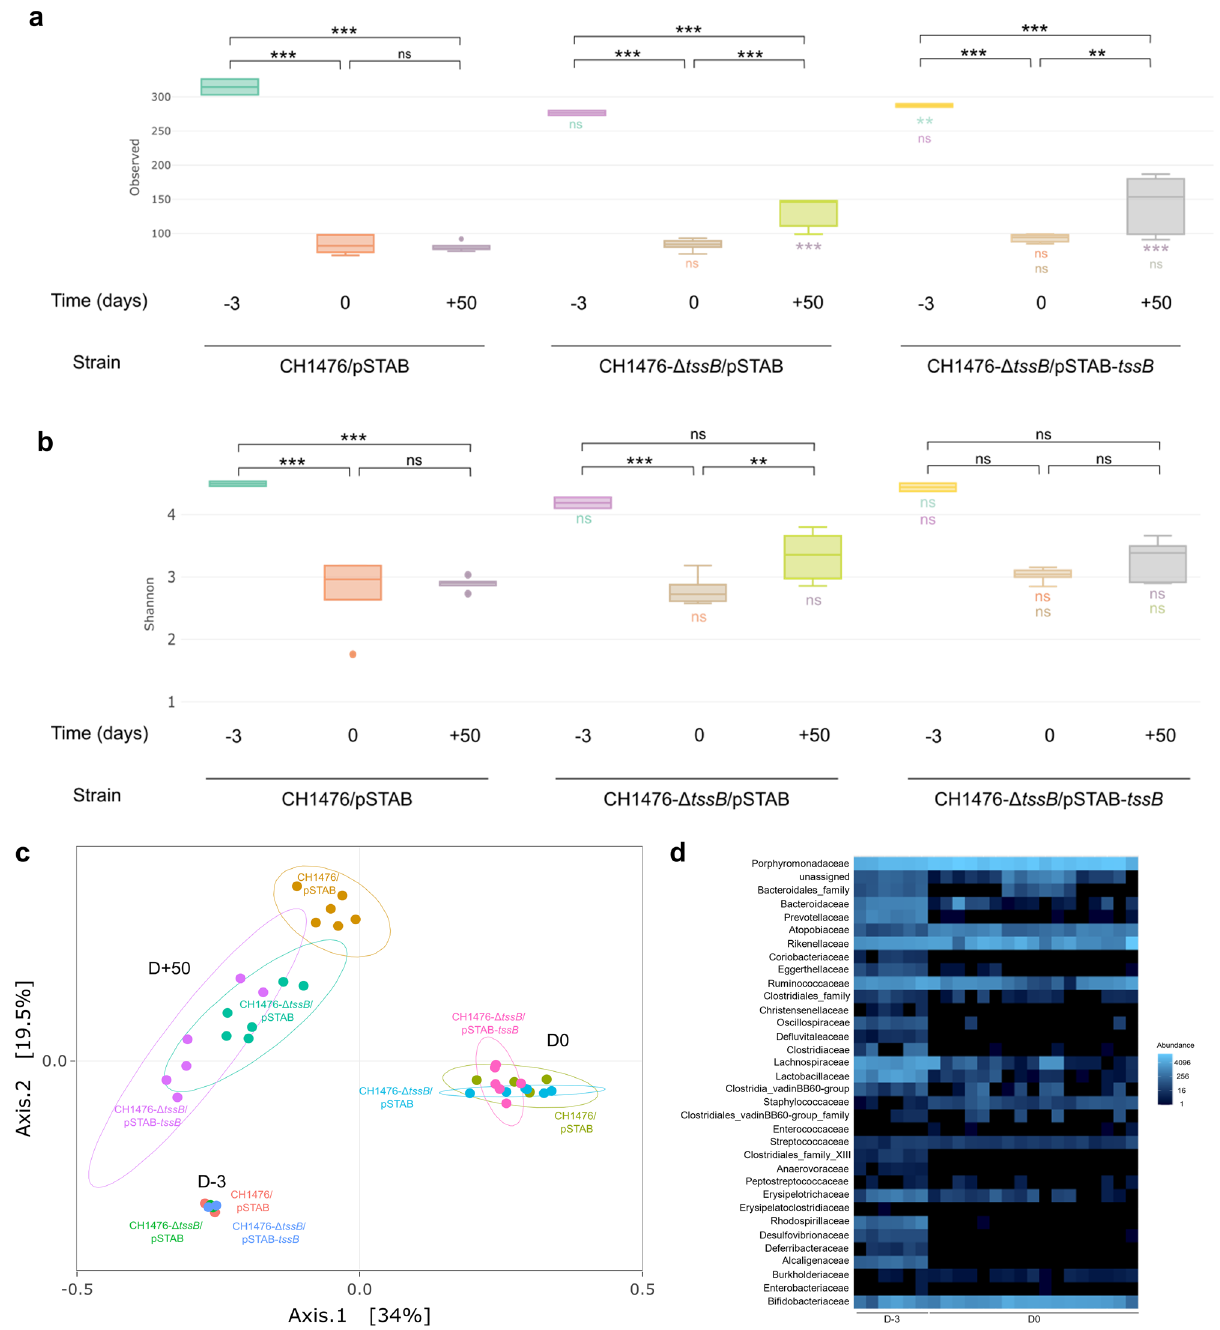
Figure 4. Modulation of gut microbiome of K. pneumoniae -infected mice correlated with the presence of T6SS-1. Alpha diversity richness: Observed index (a) and Shannon index (b) based on 16S rRNA genes from CH1476 (CH1476/pSTAB), T6SS-1 derived mutant (CH1476-Δ tssB /pSTAB) and T6SS-1 derived mutant trans-complemented (CH1476-Δ tssB /pSTAB- tssB ) infected mice. Data are expressed as median ± minimum and maximum values. (c) Principal-coordinate analysis plot (PCoA) of the gut microbiota based on the results of the unweighted UniFrac non-metric multidimensional scaling (NMDS). Each point represents a mouse. (d) Clustering heatmap of family raw abundances in fecal microbiota of mice before (D-3) and after streptomycin treatment (D0). Blue denotes increased abundance, and black denotes decreased abundance. Statistical analysis: one-way ANOVA with post-hoc Tukey HSD test; * P < 0.05, ** P < 0.01, *** P < 0.001, and ‘ns’ indicates that the difference is not significant; a color code indicates differences between mice groups at the same time